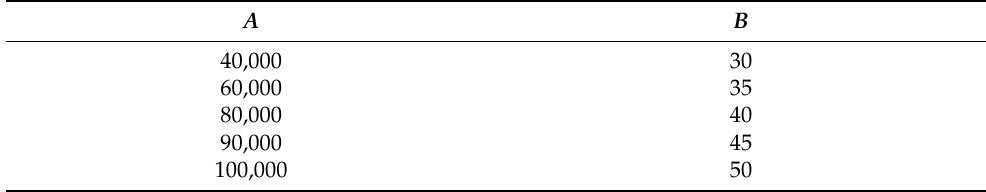
Table 1. Estimated number of passengers A and prices B of a single ticket.